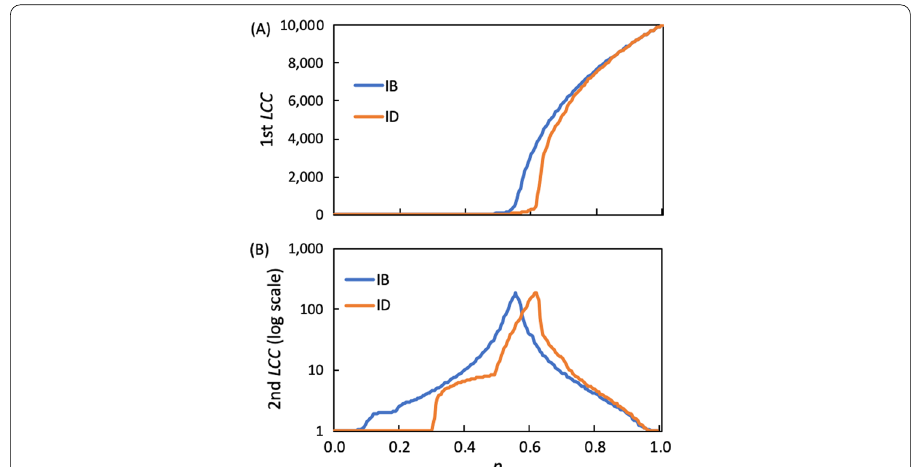
Fig. 3 Simulation result using ID and IB strategies for the non‑modular network with N average degree (cid:31) k (cid:30) 4 with: A Size of the first largest connected component (1st LCC ) and B the second = largest connected component (2nd LCC ) as a function of the occupation probability p . The result is averaged over 100